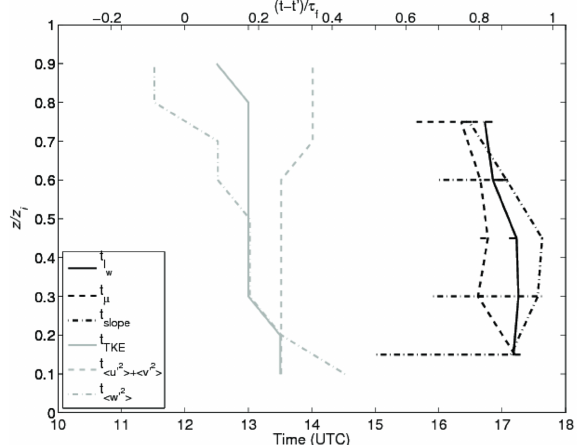
Figure 13. Vertical profiles of the timings of changes observed in the evolution of the TKE, the vertical and horizontal variances, l v , µ , and the inertial subrange slope of w spectra. t (cid:48) is defined as the time when H is maximum (i.e. at 12:00